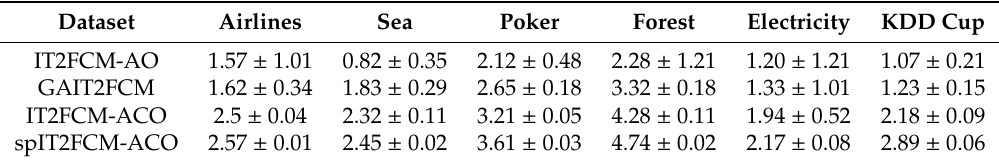
Table 3. Evaluation of SC